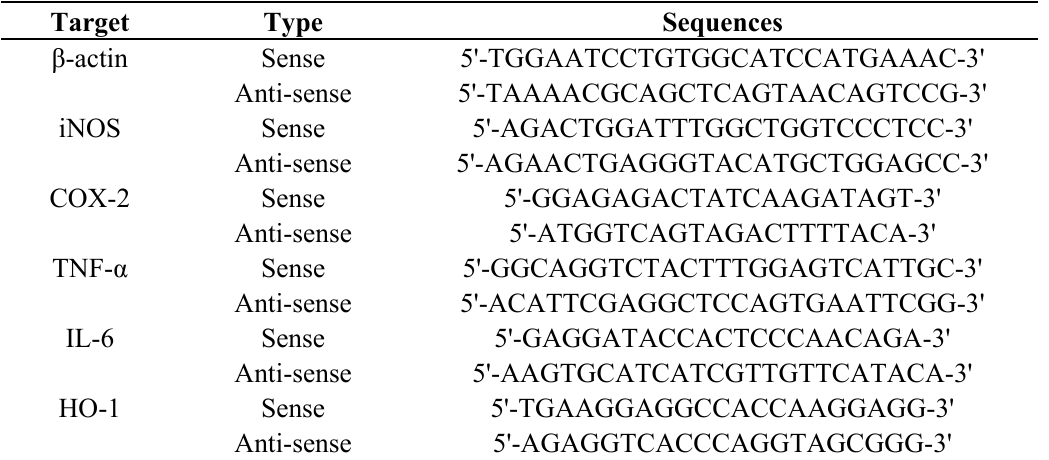
Table 2. Primer sequences used for RT-PCR in this study.